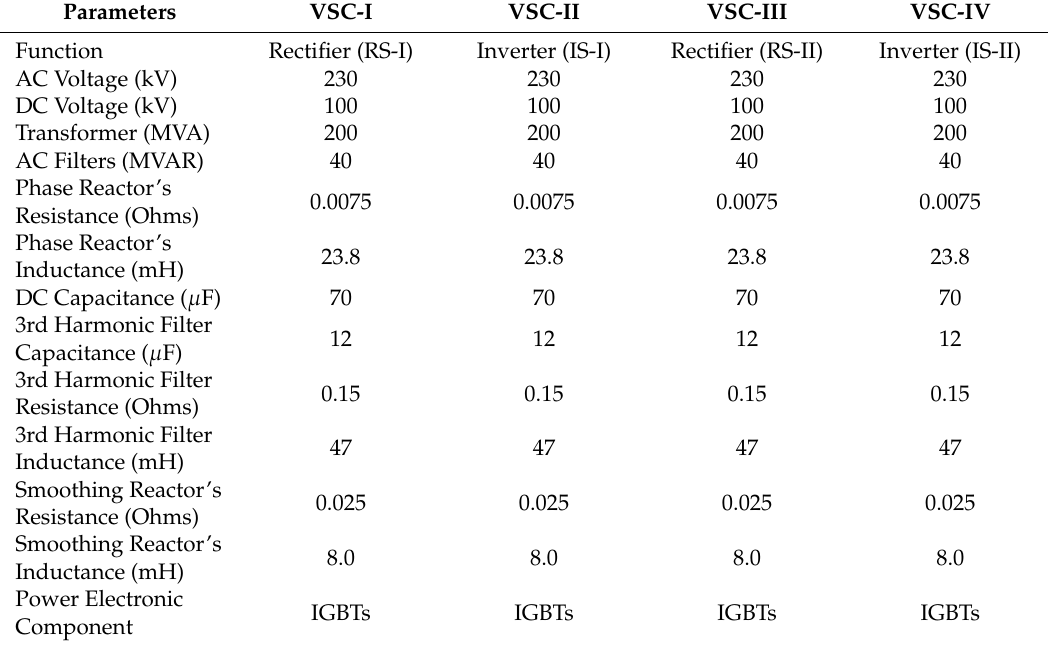
Table A1. Parameters of the test